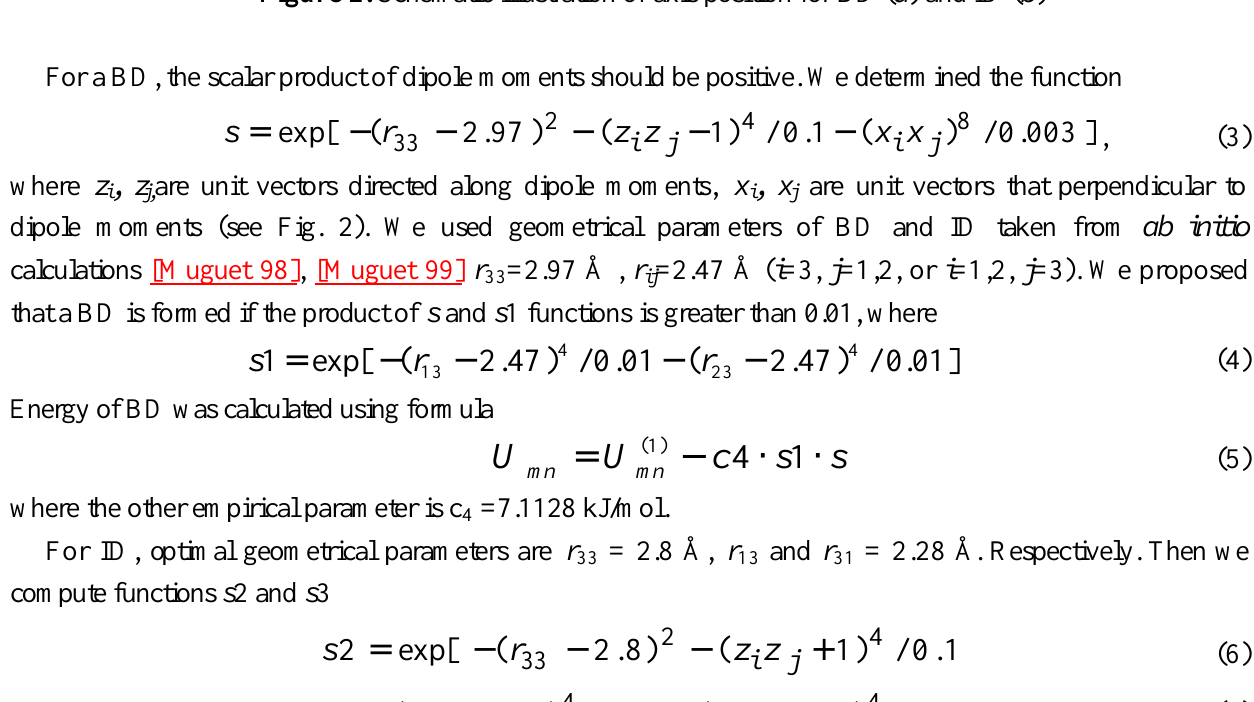
Figure 2. Schematic illustration of axis position for BD ( a ) and ID ( b